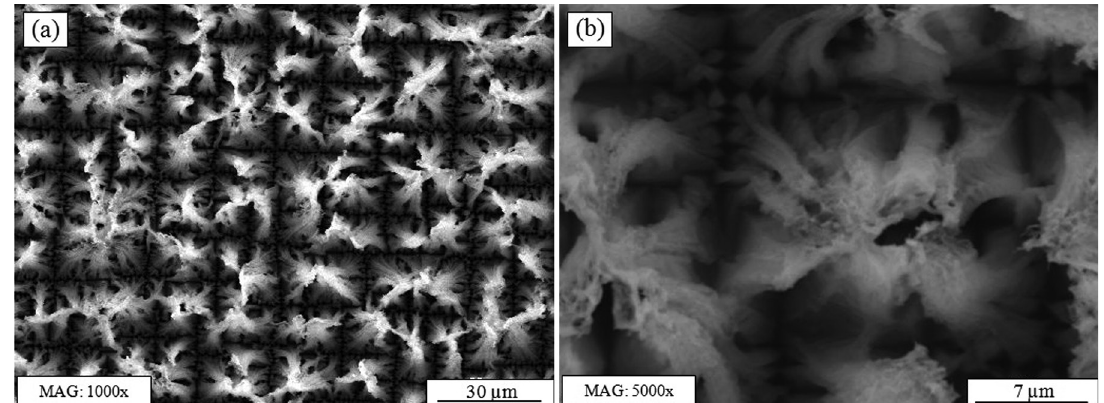
Figure 1. SEM images of porous silicon, in different magnifications (a) 1000x (b)